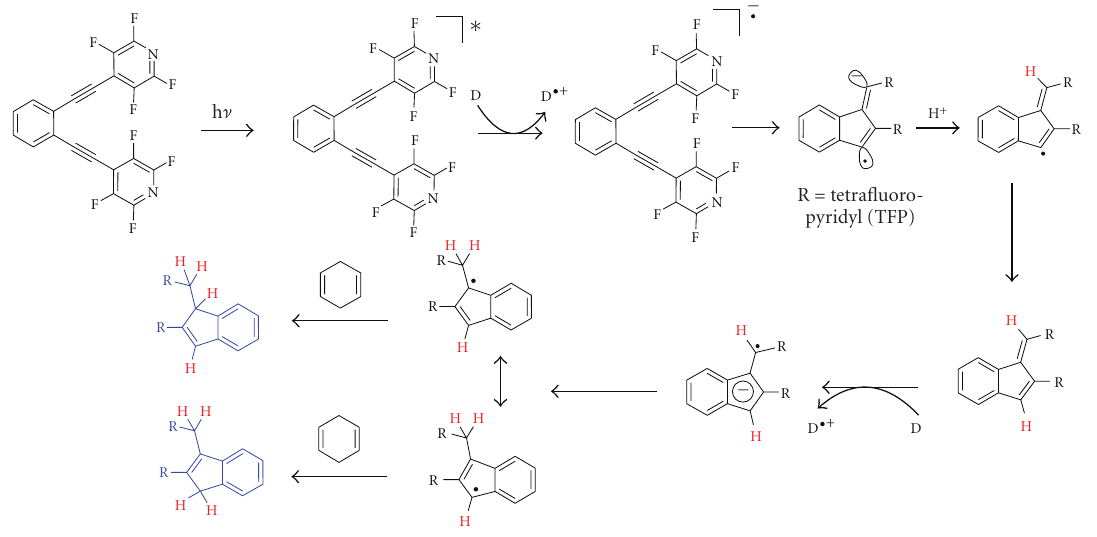
Scheme 1: C1–C5 photocyclization of bis-TFP-enediyne and proposed mechanism in the proximity to DNA (four abstracted hydrogens are shown in red, TFP =